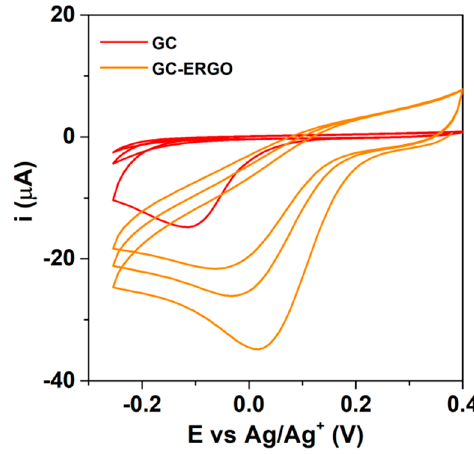
Figure 2. Cyclic voltammograms recorded in a 1 mM solution of 4-ethynylphenyldiazonium tetrafluoroborate (100 mV s − 1 ) at GC and GC-ERGO electrodes.